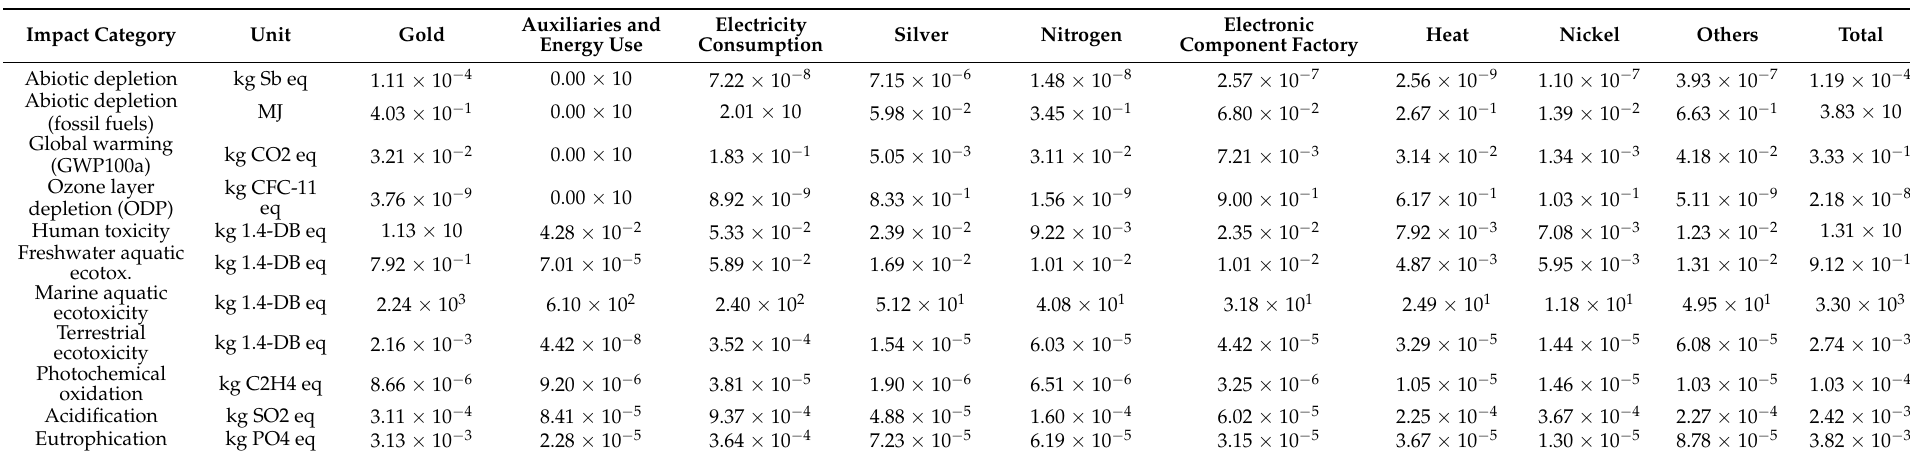
Table 7. Detailed study of the environmental impact of diode AZ23C10 (impacts for 1 g of